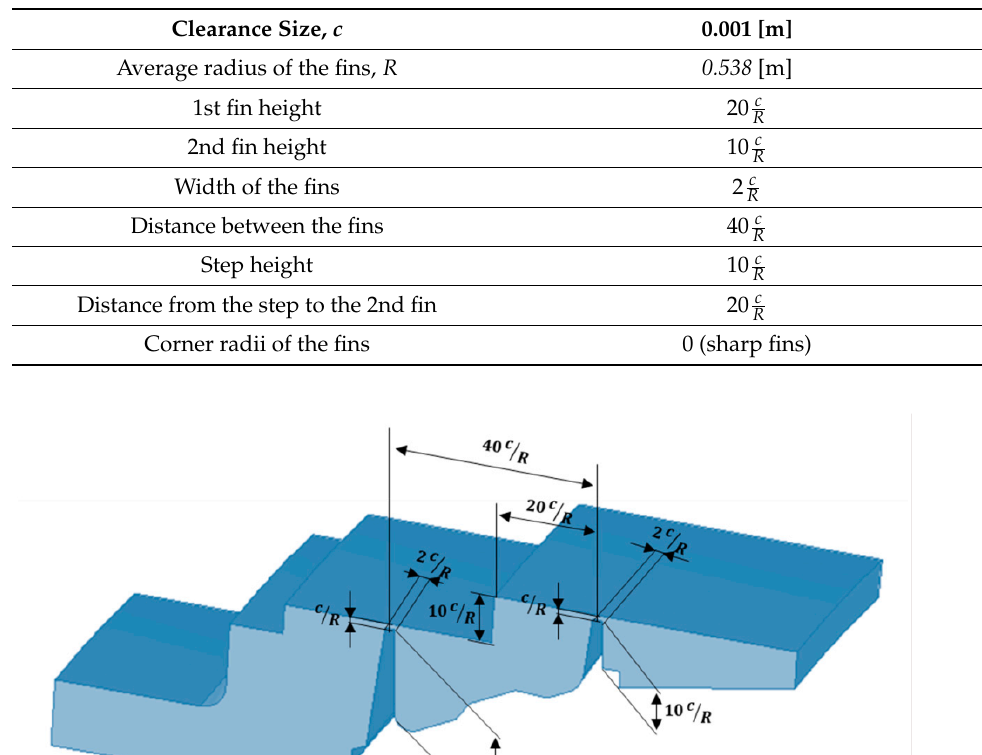
Table A1. Geometrical details of the outer air seal investigated in the study.